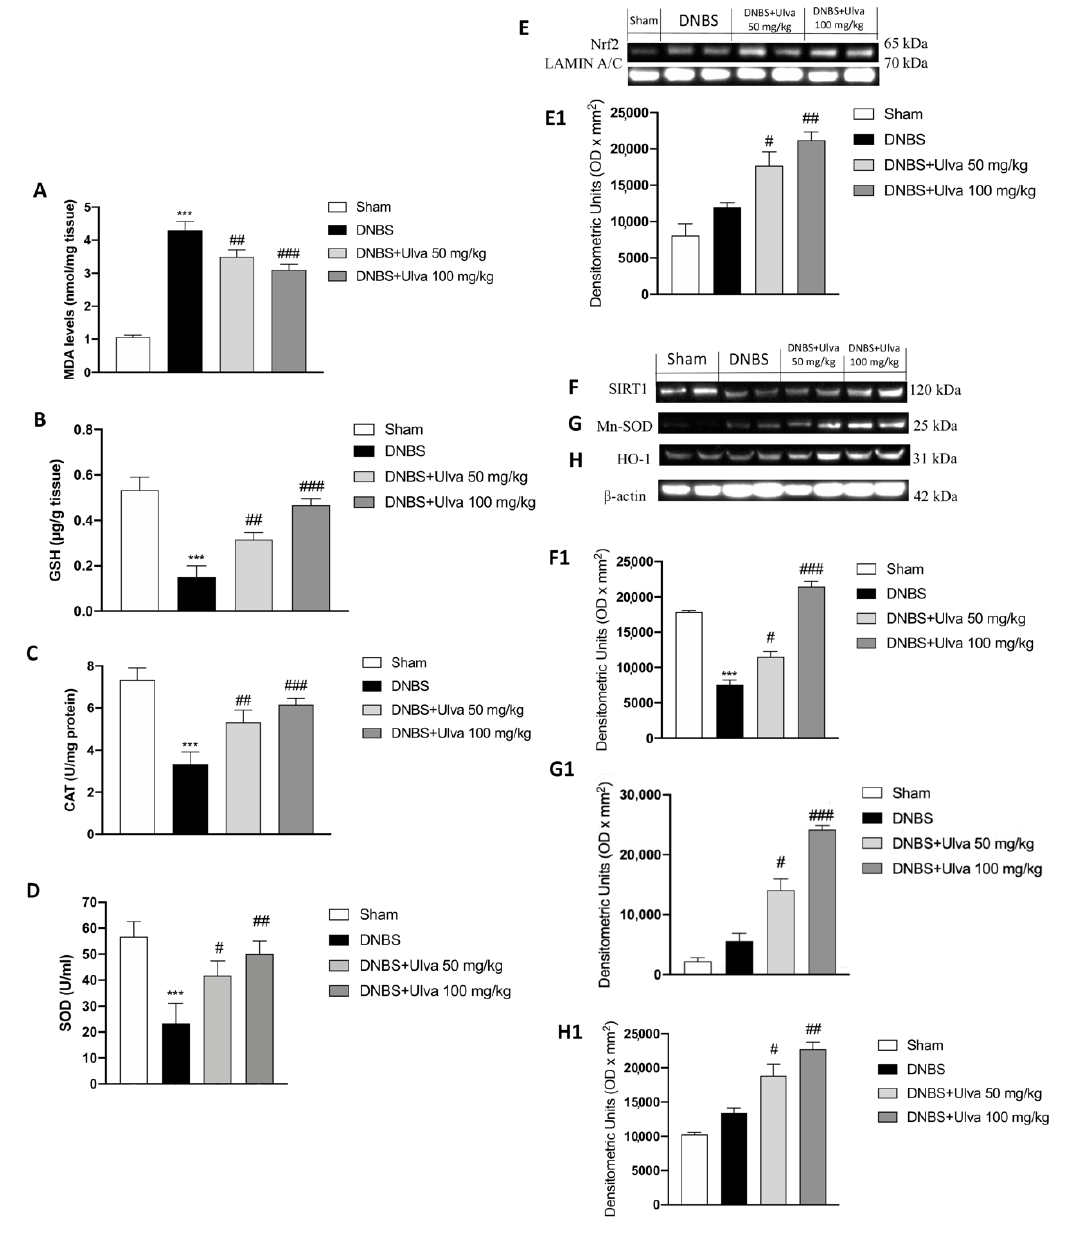
Figure 7. Effect of Ulva pertusa on antioxidant system and SIRT1/Nrf2 pathway. The administration of Ulva pertusa at the dose of 50 mg/kg, but more powerfully at the dose of 100 mg/kg, was able to strengthen the antioxidant response upregulating GSH, CAT, and SOD levels ( B – D ) and decreasing MDA levels ( A ). Furthermore, Ulva pertusa administration increased the expression of the nuclear factor Nrf2 ( E ), densitometric analysis ( E1 ), and upregulated the enzymes MnSOD ( G ), densitomet- ric analysis ( G1 ) and HO-1 ( H ), densitometric analysis ( H1 ). In addition, treatment with Ulva , at both doses, significantly restored SIRT1 levels which had previously been reduced by DNBS-in- duced colitis ( F ), densitometric analysis ( F1 ). Data are representative of at least three independent experiments. Values are means ± SD. One-way ANOVA test followed by Bonferroni. One-way ANOVA test. *** p < 0.001 vs. Sham; # p < 0.05 vs. DNBS; ## p < 0.01 vs. DNBS; ### p < 0.001 vs. DNBS. 4. Discussion The discovery of new molecular targets and unconventional care is an important goal for research and management of the intestinal disease. Concerning this, compounds of natural origin can show comparatively fewer side effects as compared to conventional